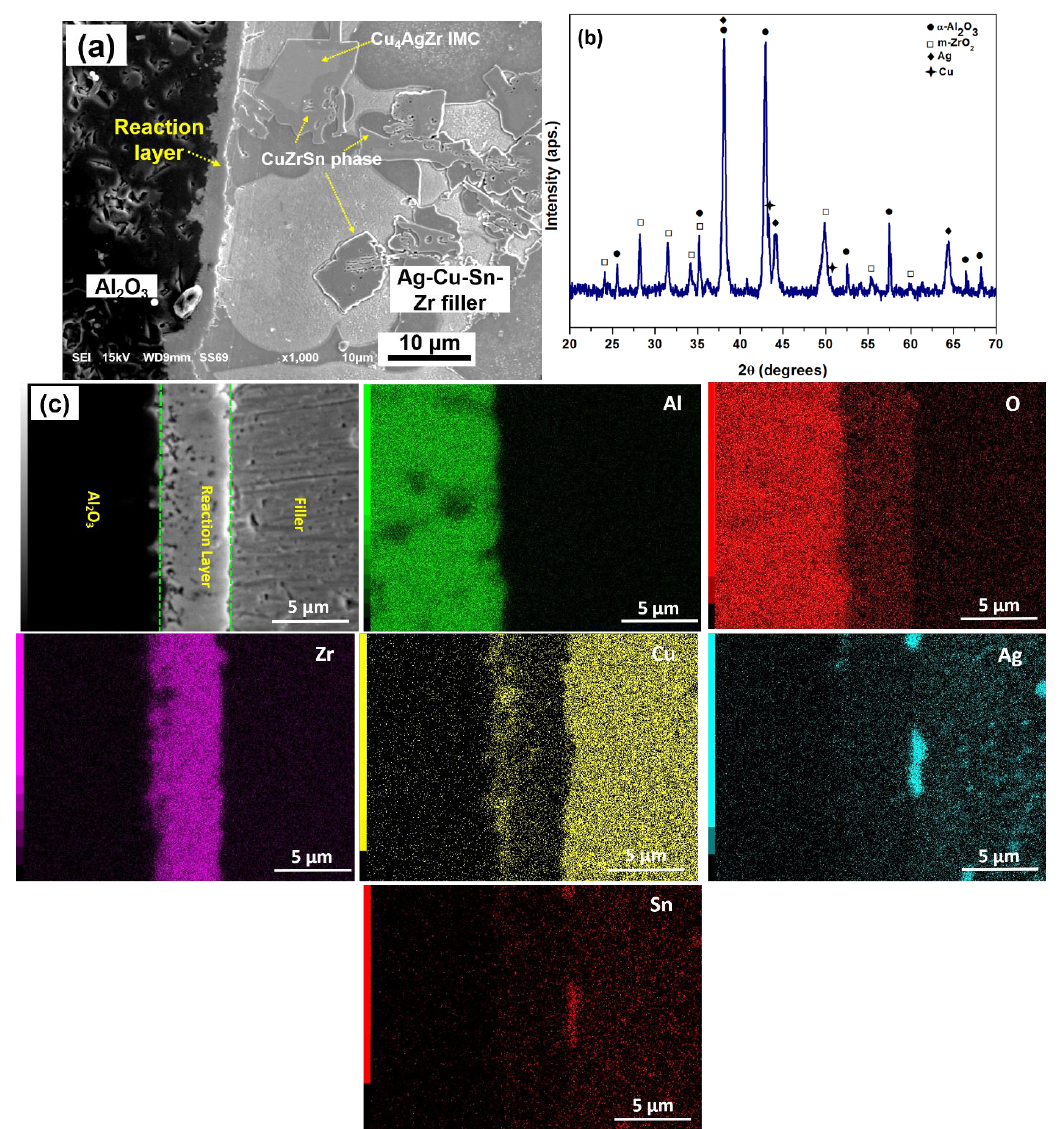
Figure 5. Al 2 O 3 /Cu joints brazed using Ag-18Cu-6Sn-3Zr filler: ( a ) interface microstructure, ( b ) XRD pattern of reaction zone adjacent to Al2O3 and ( c ) elemental mapping of brazed Al2O3/Ag-18Cu-6Sn-3Zr interface.